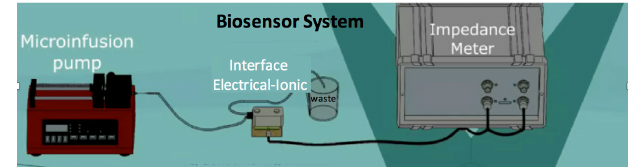
Fig. 1. Components of the cDNA biosensor